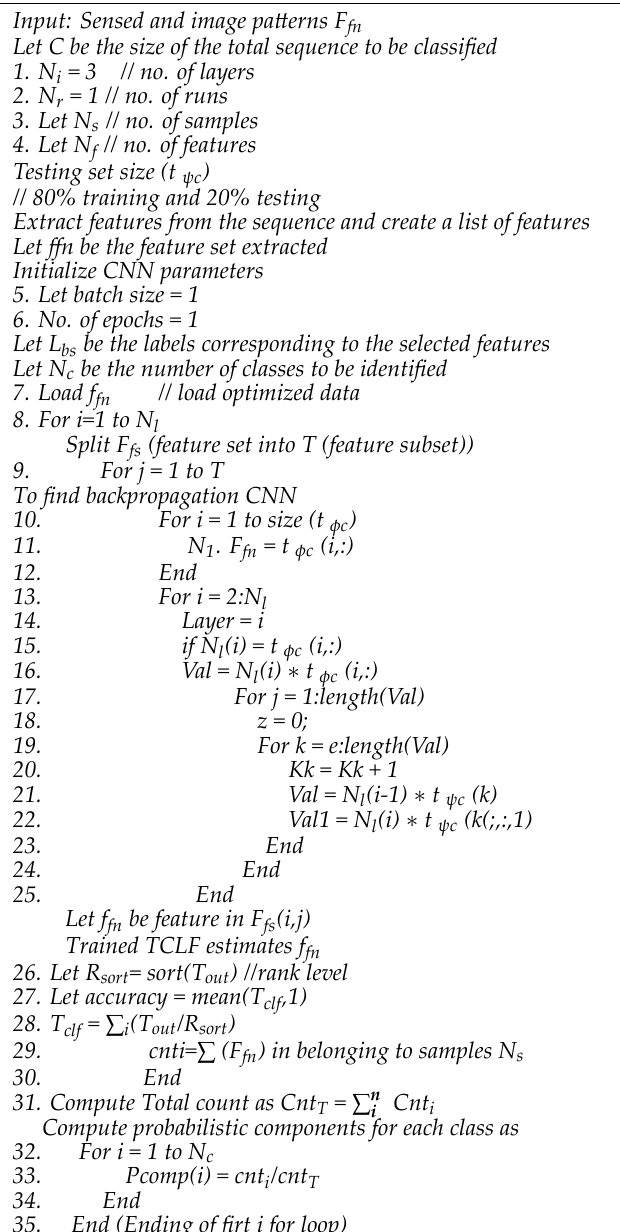
Algorithm 1. ML CNN classification